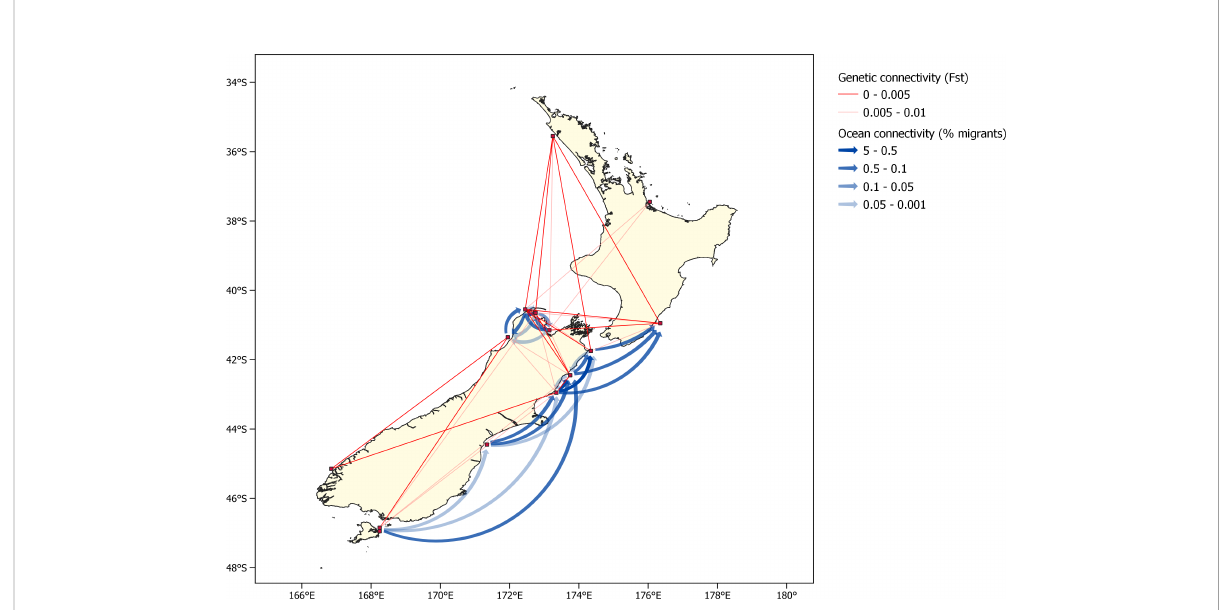
FIGURE 8 Oceanographic connectivity, presented as the proportion of particles released from each population that settle in each destination population, and pairwise F ST between all populations. As oceanographic connectivity from the two Stewart Island populations is very similar, only Horseshoe Bay is shown for